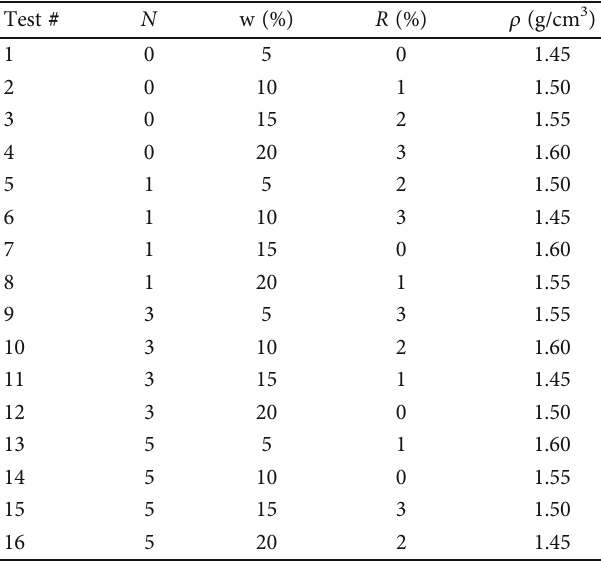
Table 3: Orthogonal